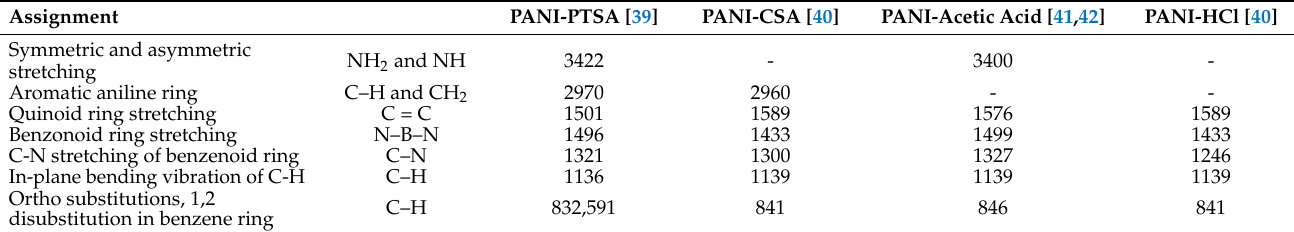
Figure 2. FT-IR spectra of synthesized PANI samples. Table 3. Comparison of functional group peaks in the FT-IR spectra of the PANI samples.